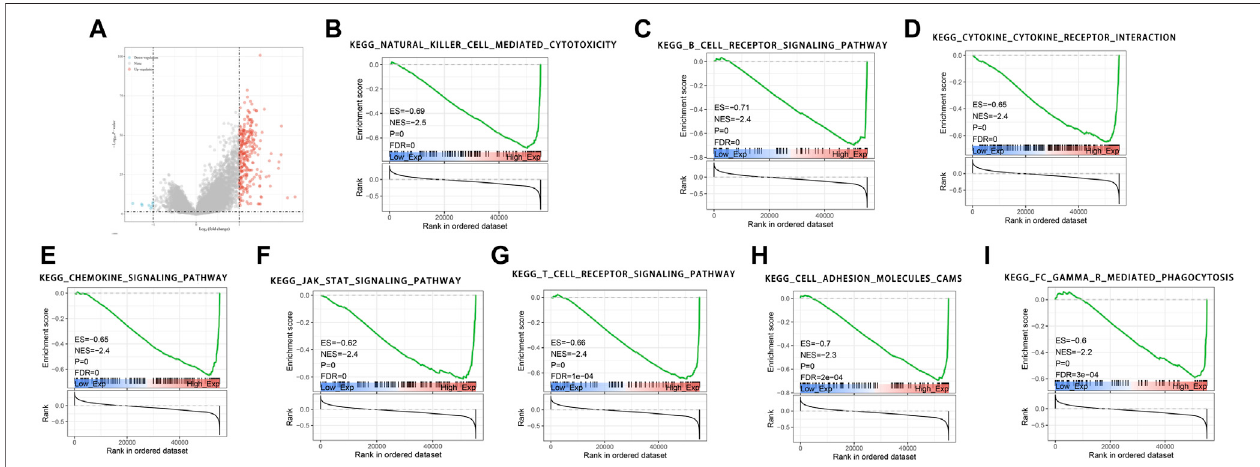
FIGURE 4 | GSEA pathways enriched in samples with high lymphoid-restricted membrane protein ( LRMP ) expression. Two hundred and fi fty-seven genes were signi fi cantly upregulated and eight genes were signi fi cantly downregulated in the high-expression LRMP group (A) . The results indicate that the natural killer cell- mediated cytotoxicity (B) , B cell receptor signaling pathway (C) , cytokine-cytokine receptor interaction (D) , chemokine signaling pathway (E) , JAK-STAT signaling pathway (F) , T cell receptor signaling pathway (G) , cell adhesion molecules CAMs (H) , FC gamma R mediated phagocytosis (I) were signi fi cantly enriched in lung adenocarcinoma (LUAD) samples with high LRMP